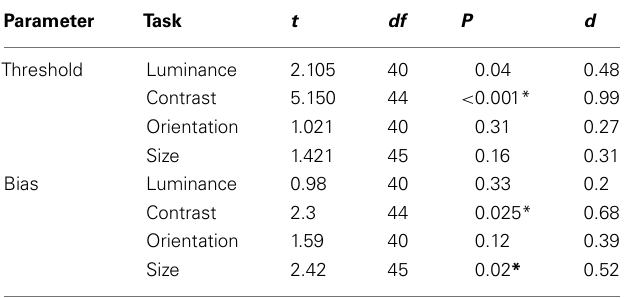
Table 3 |Weighted t -tests comparing patient and control group biases and thresholds.